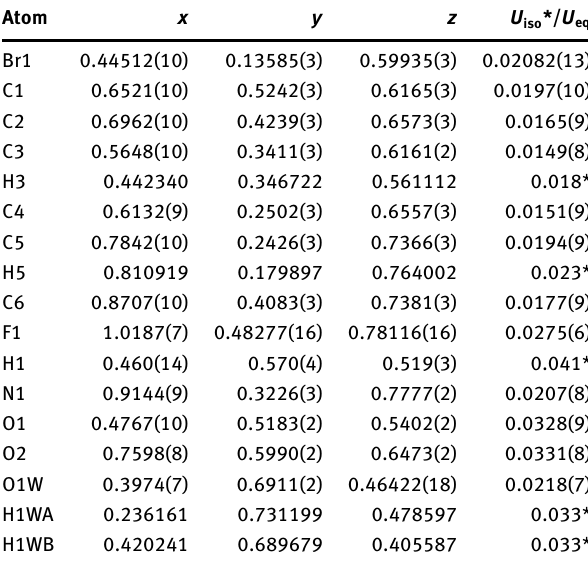
Table 2: Fractional atomic coordinates and isotropic or equivalent isotropic displacement parameters (Å 2